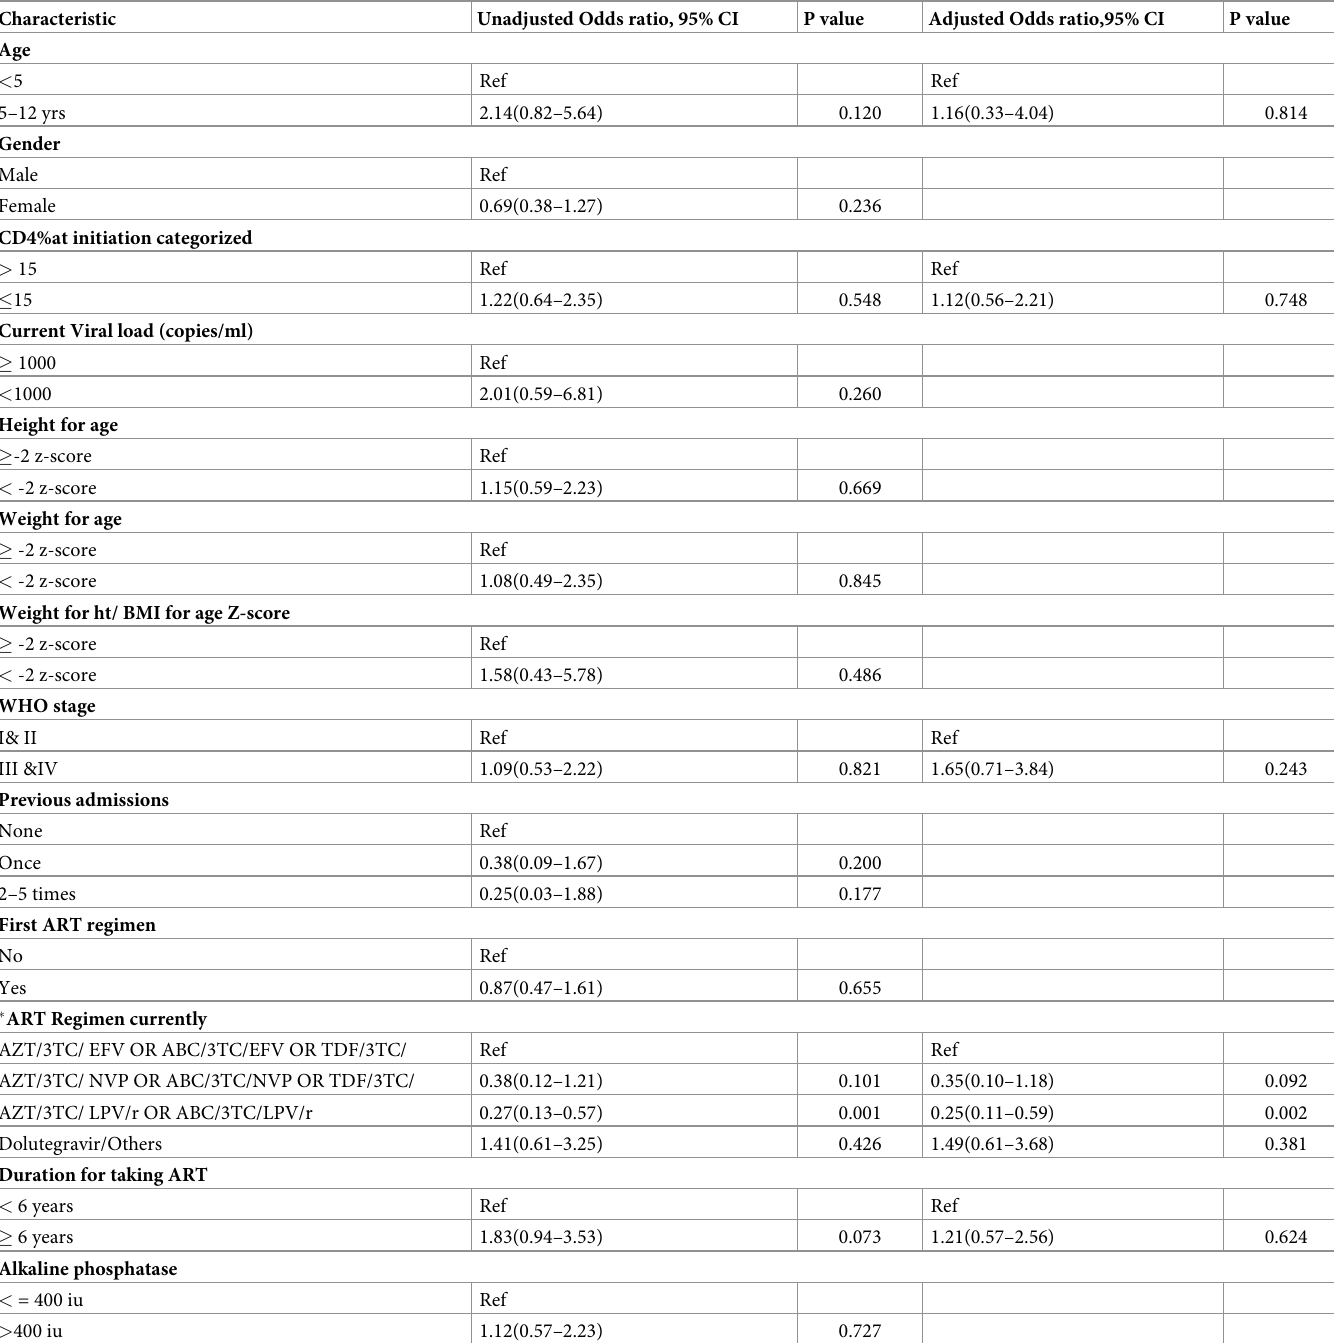
Table 2. Factors associated with suboptimal vitamin D (serum 25(OH)D < 30 ng/ml) among HIV infected